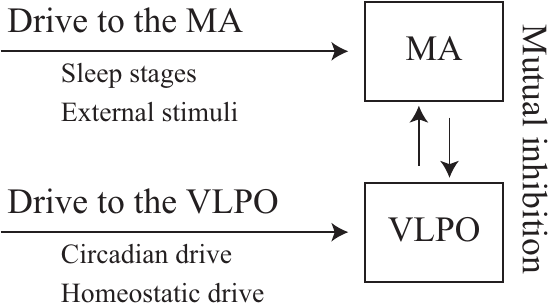
Figure 1. Illustration of the schematic diagram of the Phillips–Robinson model. The monoaminergic (MA) and ventrolateral preoptic nucleus (VLPO) nuclei are activated by external drives that influence sleep stages, external stimuli, as well as internal circadian and homeostatic drives. Mutual inhibition between the MA and VLPO comprises the sleep-wake